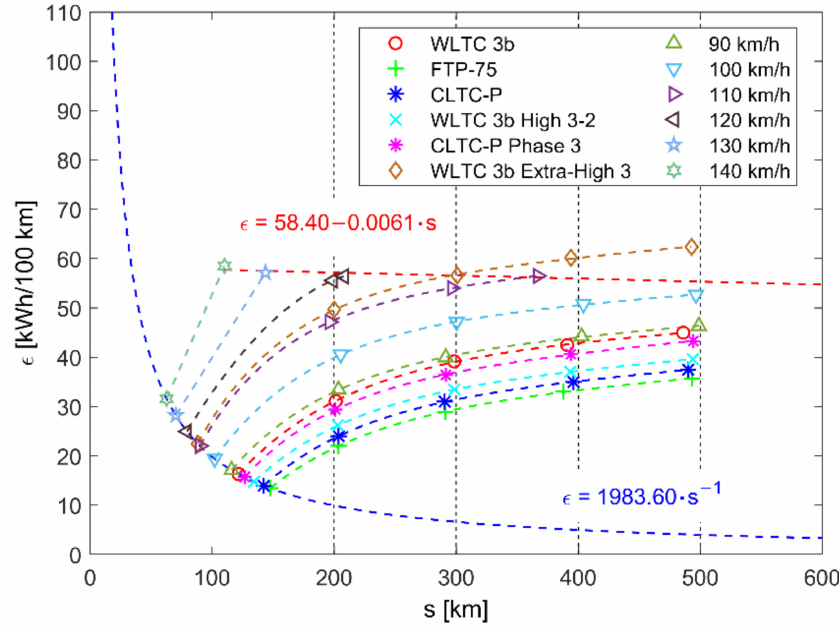
Figure 17. Specific energy consumption results for BEV mode and EREV drive (four EREV range targets indicated with dashed vertical lines) in various drive cycle conditions. Vehicle mass is equal to 1500